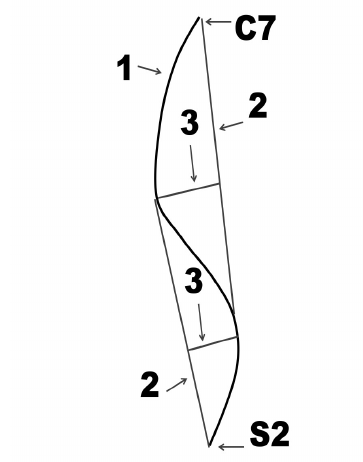
Figure 2 - Analysis of the symmetry line representation for the right and left arrows, 1 = Symmetry line; 2 = Strings; 3 = Scoliosis